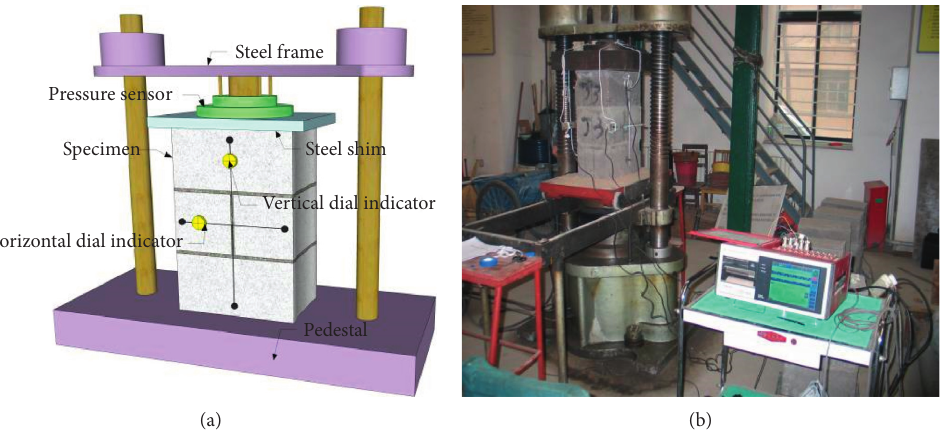
Figure 9: Specimens employed for testing compressive strength. (a) Schematic diagram; (b) actual diagram.